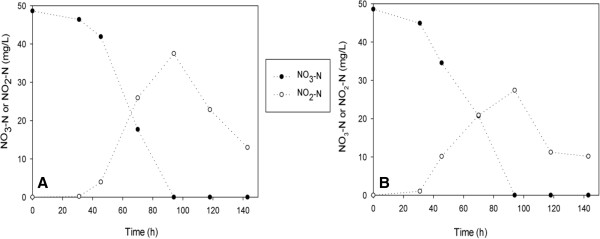
The variations of NO3--N and NO2--N in heterotrophic batch experiments at different initial BrO3- concentrations [19,7 mg/L methanol]. (A) 100 μg/L BrO3-(B) 500 μg/L BrO3-.